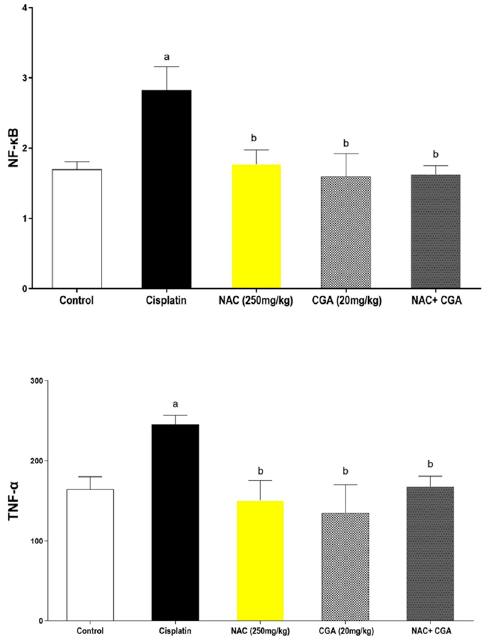
Figure 2. Effects of NAC and/or CGA on Cisplatin-Mediated Changes in Renal Expressions of NF-kB and TNF- α . Control: normal rats; Cisplatin: Cisplatin (7 mg/kg, IP) injected rats; NAC (250 mg/kg): Cisplatin-injected rats treated with NAC (250 mg/kg/day p.o.) one week before and after cisplatin injection; CGA (20 mg/kg): Cisplatin-injected rats treated with CGA (20 mg/kg/day p.o.) one week before and after cisplatin injection; NAC + CGA: Cisplatin-injected rats treated with NAC (250 mg/kg/day p.o.) and CGA (20 mg/kg/day p.o.) one week before and after cisplatin injection. Values are mean ± SEM (n = 5). a : compared to the control group; b compared to the cisplatin group. For NF-kB (F = 5.58, df = 4, p = 0.0067) and for TNF- α (F = 5.56, df = 4, p = 0.0025). p values were evaluated using one-way ANOVA followed by Tukey – Kramer as a post-hoc test. NF-kB: Nuclear factor- κ B; TNF- α : Tumor necrosis factor alpha; NAC: N-acetylcysteine; CGA: Chlorogenic acid.